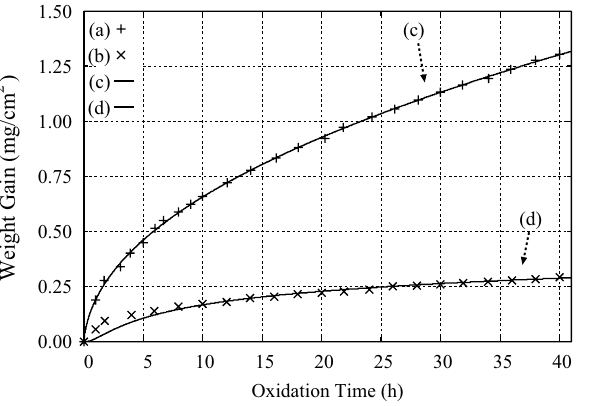
Figure 3. Experimental results on the oxidation of ( a ) unimplanted and ( b ) implanted (with 10 16 ion/cm 2 Ce) Ni–30 Cr alloys at T mole percent, respectively, after Patibandla et al. 23 . ( c ), ( d ) Results of the calculations by using Eqs. (1) and (3) with the use of ( c ) B